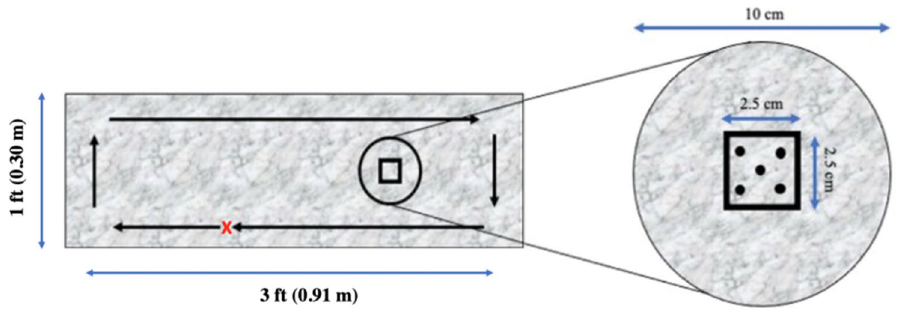
Figure 1. Schematic diagram of the Formica surface used for disinfectant towelette efficacy testing against C. auris Satoh et Makimura (ATCC MYA-5001). Candida auris cells were spot inoculated on the i-zone (black dots), marked within a square of 2.5 cm × 2.5 cm inscribed within a circular pattern of diameter 10 cm on the Formica sheet. After inoculation, the whole surface (3 ft 2 or 0.28 m 2 ) was wiped in a clockwise pattern as indicated by the black outlined arrows. Samples were collected from the marked circular zone post-disinfection to recover C. auris